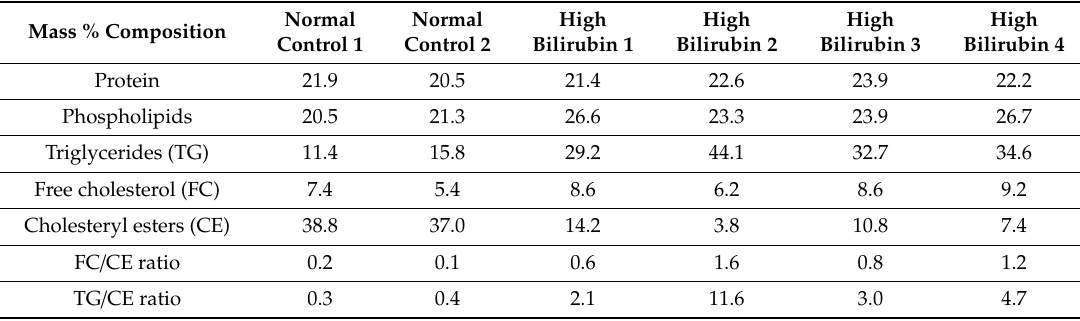
Table 2. Percentages of lipid and protein by mass in the LDL fraction isolated from subjects with normal ( n = 2) or high bilirubin concentrations ( n = 4).